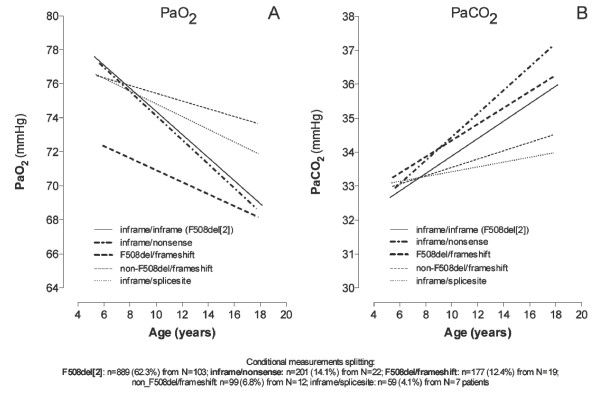
Progression with age based on measurements of A) PaO2 and B) PaCO2 within the 5 genetic subgroups (miscellaneous excluded), obtained by linear mixed model LMM analysis. Patient numbers are given by N, measurement numbers by n. Data distribution over age was equal for each genetic subgroup.